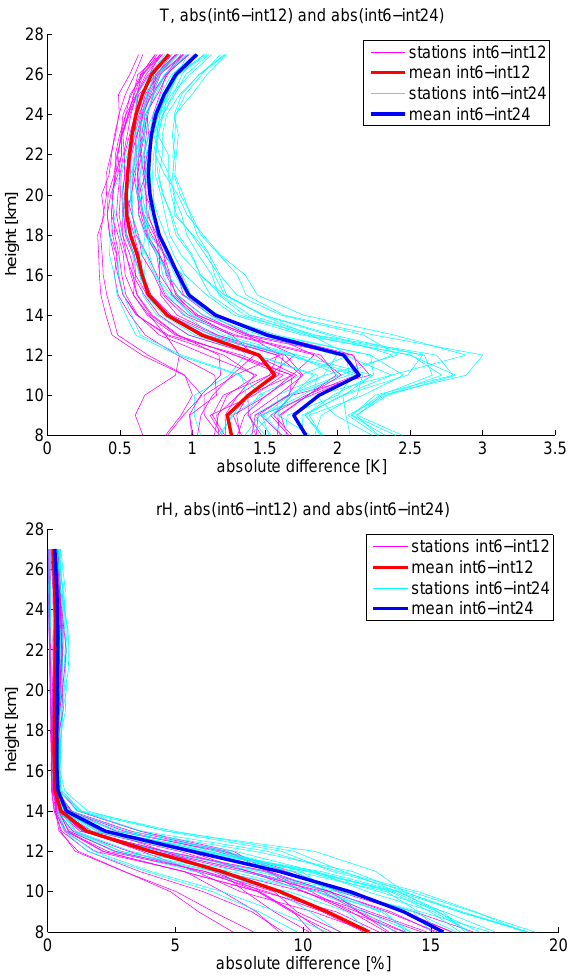
Figure 18. Difference between the model run with the lowest extent of the damping layer at 28km to the standard with rdheight = 22 for T (top) and RH (bottom). Shown is one profile for each station and the mean of all